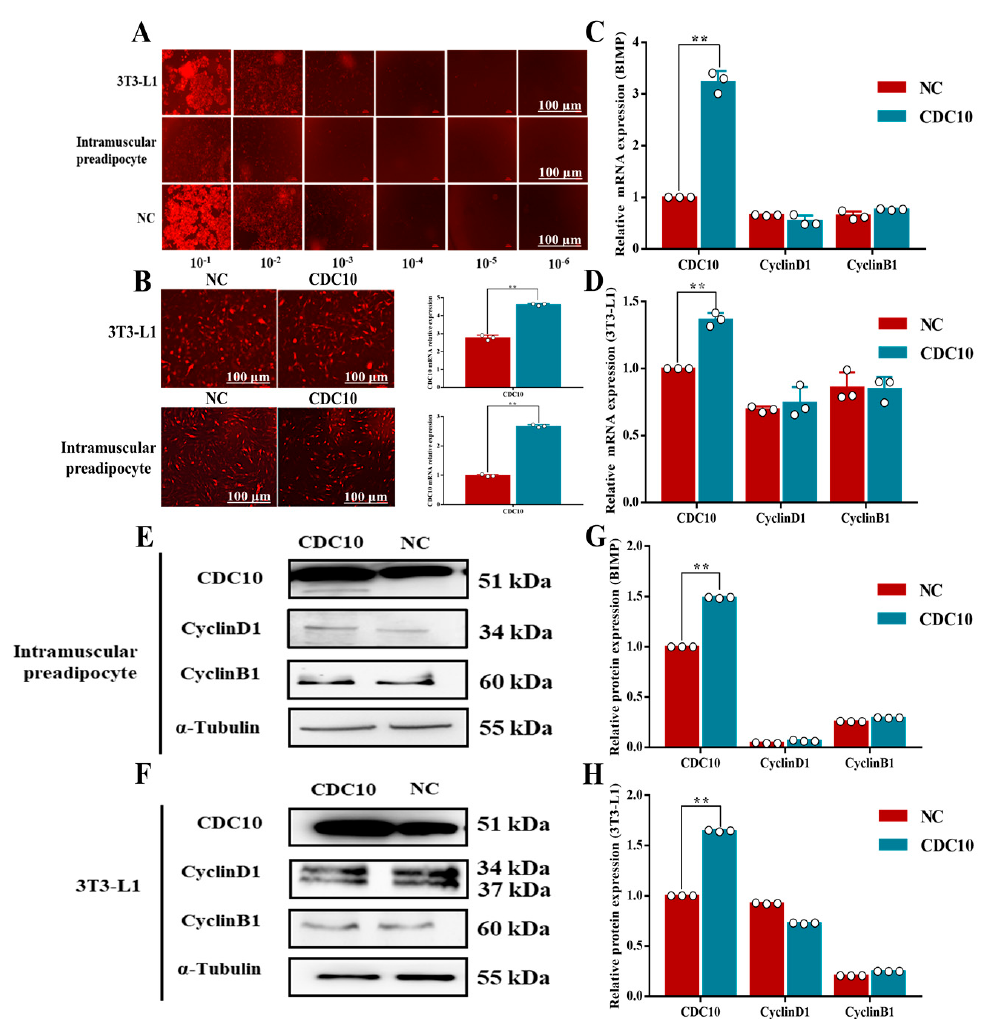
Figure 5. The effect of CDC10 overexpression on the proliferation of bovine intramuscular preadipocyte (BIMP) and 3T3-L1 cells was detected by RT-PCR and Western blot assay. BIMP and 3T3-L1 cells were transfected with lentivirus for 96 h during proliferation. ( A ) Determination of lentivirus titer. ( B ) Quantitative detection of the overexpression efficiency of CDC10 in BIMP and 3T3-L1 cells. ( C , D ) After overexperssion with lentivirus for 96 h, the expression levels of CDC10 , CyclinD1 , and CyclinB1 in BIMP and 3T3-L1 cells were determined by RT-PCR and normalized to the β -actin level. ( E , F ) Protein levels were assessed by Western blot analysis (small band of CDC10 in ( E ) is a non-specific band). ( G , H ) Quantitative analysis of CDC10, CyclinD1, and CyclinB1 proteins in BIMP and 3T3-L1 cells. Values are expressed as mean ± SEM ( n = 3). ** p < 0.01. RT-PCR data was normalized to control groups of CDC10